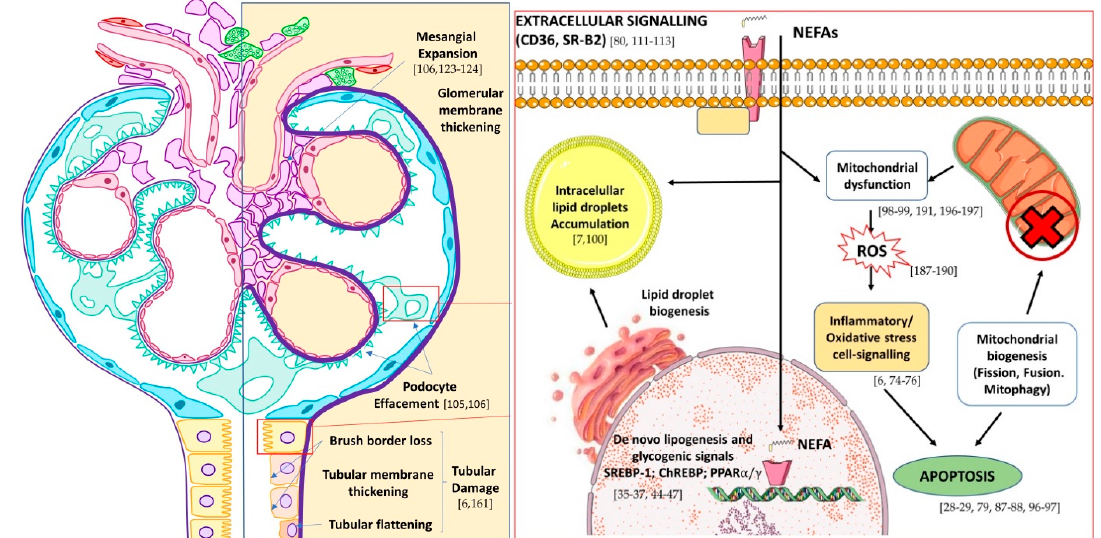
Figure 2. Effect of lipotoxicity on kidney nephron ( left ) and main pathways of action and detoxification of non-esterified fatty acids (NEFA) in podocytes and tubular cells ( right ). In brackets are shown selected references on lipotoxicity-mediated mechanisms. Adapted from Wikimedia glomerule image (CC BY-SA 4.0 Author: M. Komorniczak). Macrophages/Foam cells: The role of macrophages and foam cells in kidney lipotoxicity is